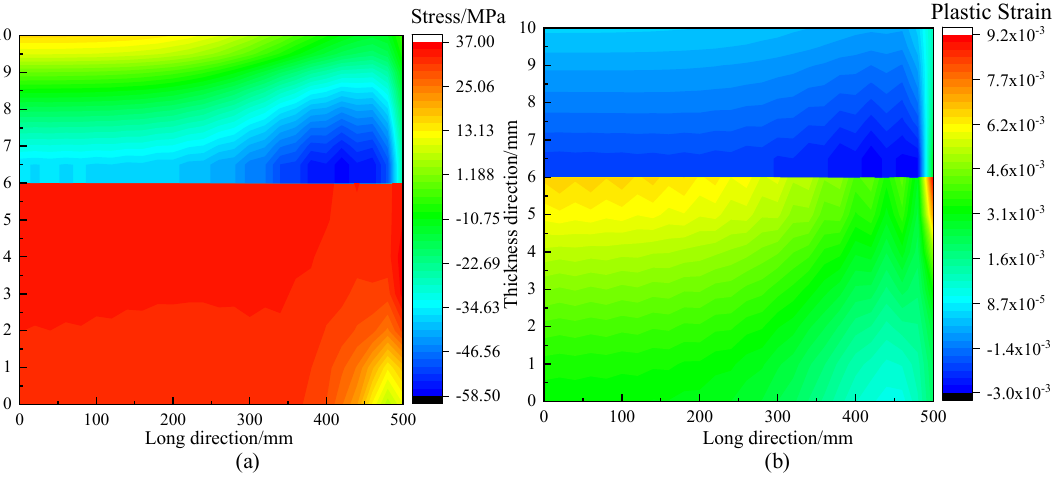
Figure 16. Distribution cloud diagram of longitudinal stress and plastic strain after heating process. ( a ) Longitudinal stress. ( b ) Longitudinal plastic strain.